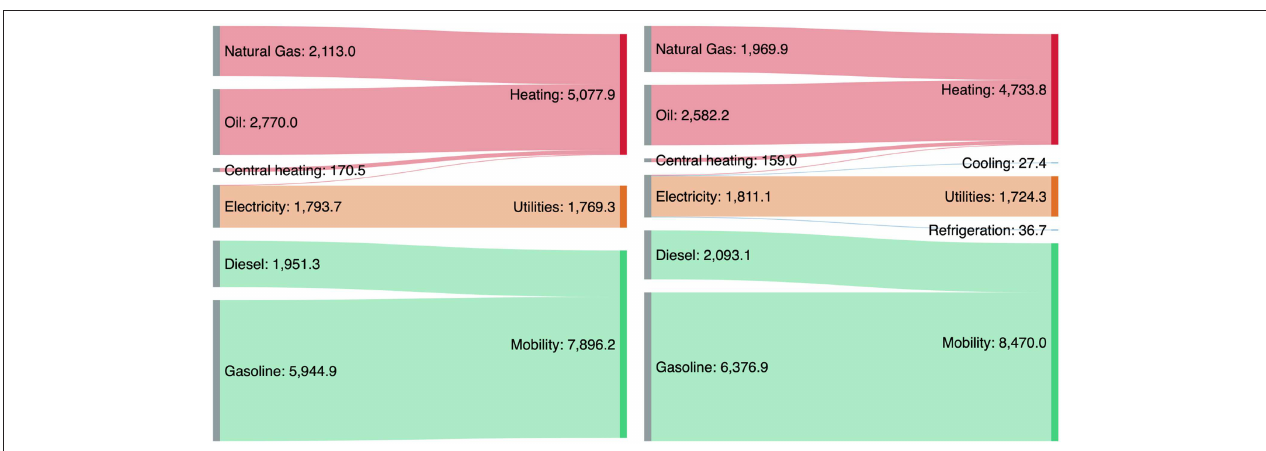
FIGURE 5 | Real profile resource consumption in Rotterdam [MWh] (Left) , Sector profile resource consumption in Rotterdam [MWh] (Right) .